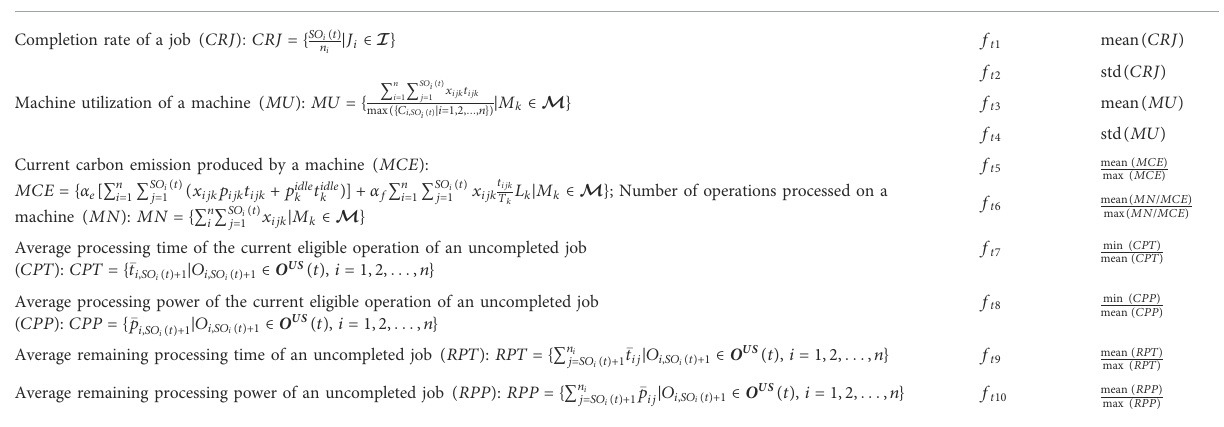
TABLE 2 Statistic-based state features. Production statistic information State